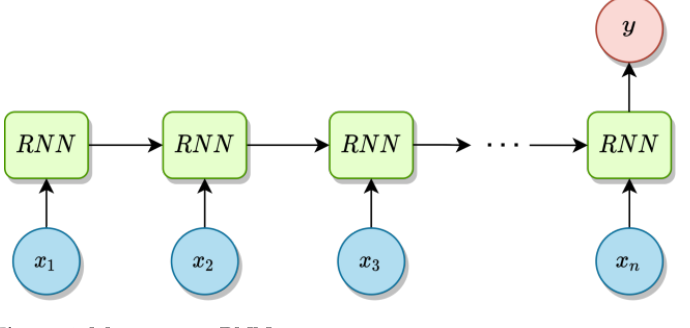
Figure 4. Many to one RNN.